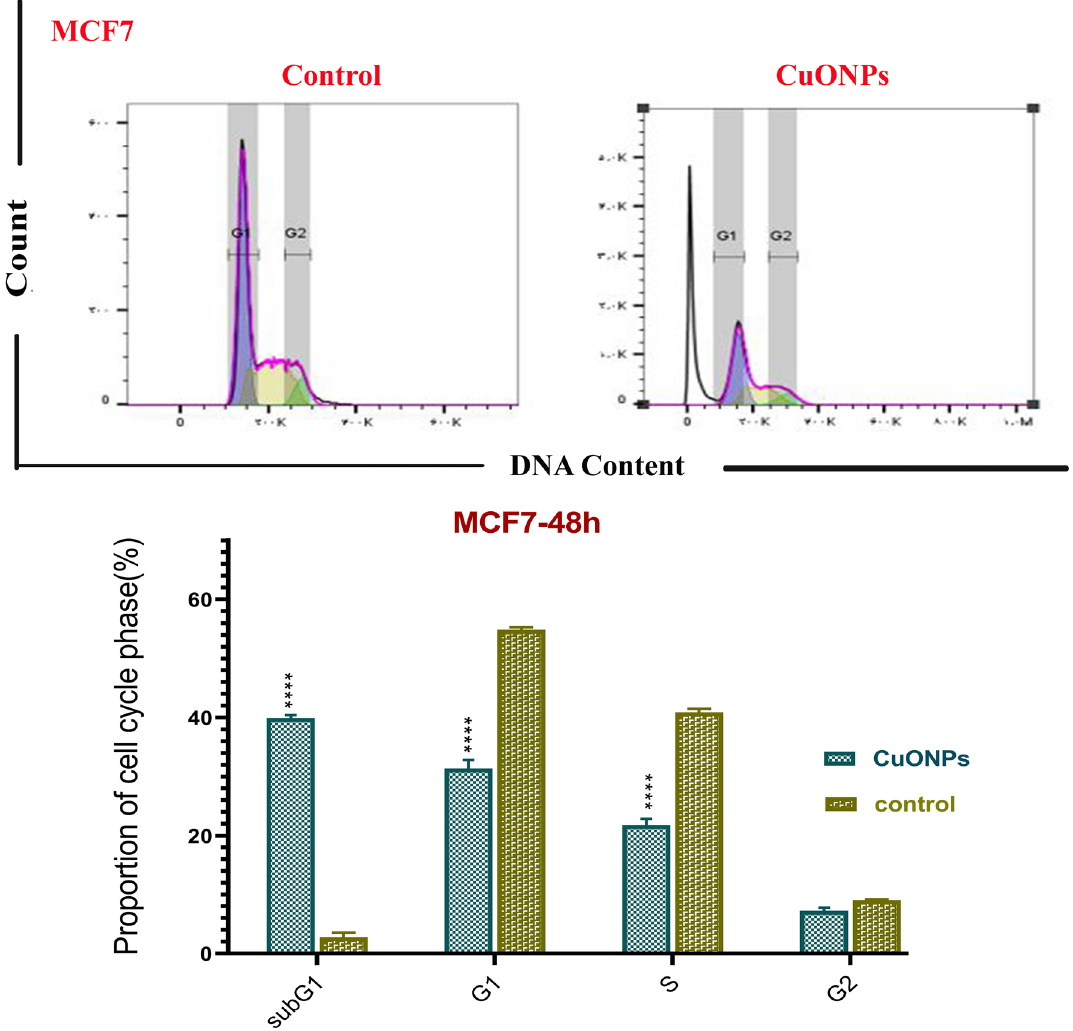
Figure 9. Cell cycle arrest in MCF7 cells treated with IC 50 concentration of BC-CuONPs. Comparison of cell cycle arrest of different phases in MCF7 cells treated with IC 50 concentrations of BC-CuONPs after 48 h treatment. ****: P <